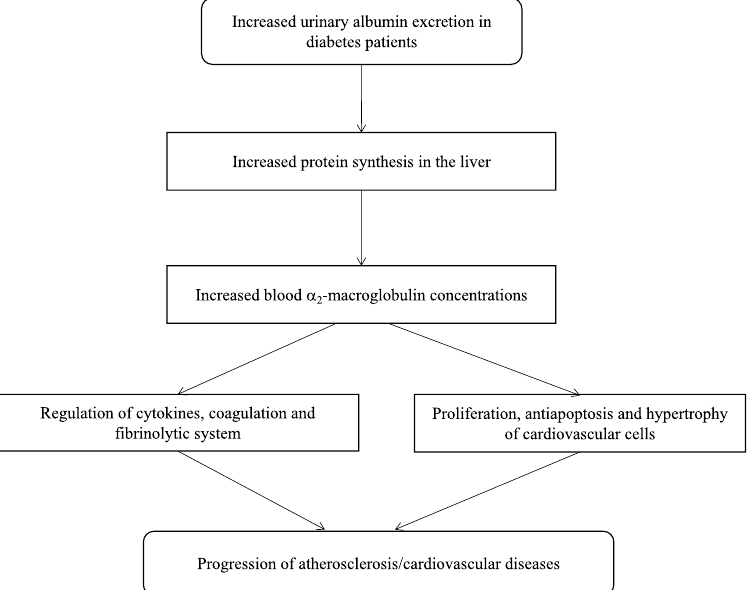
Figure 4. Flowchart for the proposed mechanistic link between albuminuria, serum α 2 -macroglobulin and cardiovascular disease in